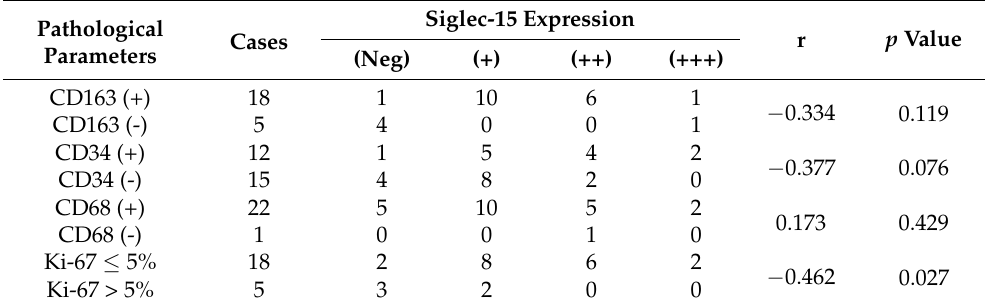
Table 2. Relationship between Siglec-15 expression on GCTB tissues and pathological parameters.